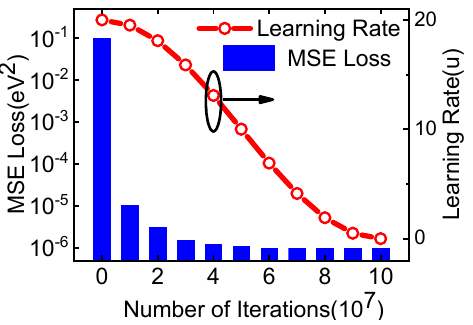
Figure 3. Mean Square Error (MSE) and learning rate with training iterations.